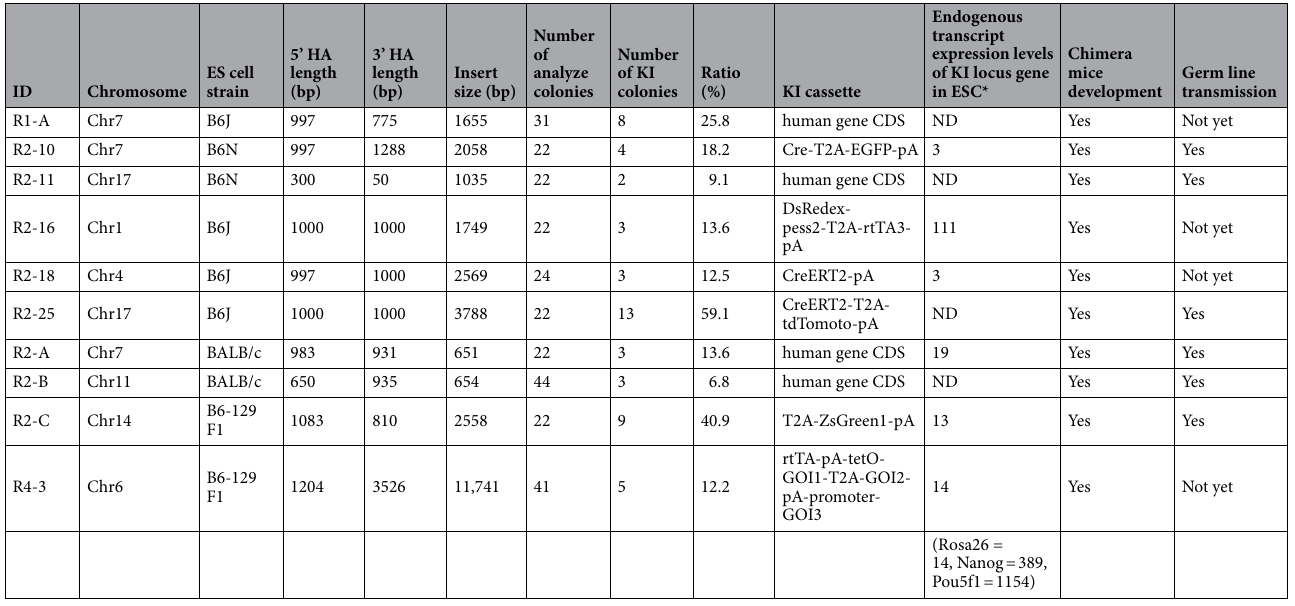
Table 1. gRNA-Cas9 RNP mediated DNA fragment KI effectively works on various genomic loci. *TPM were determined by using a public transcriptome database (https:// www. ebi. ac. uk/ gxa/ exper iments/ E- GEOD- 27843/ Resul ts) provided by